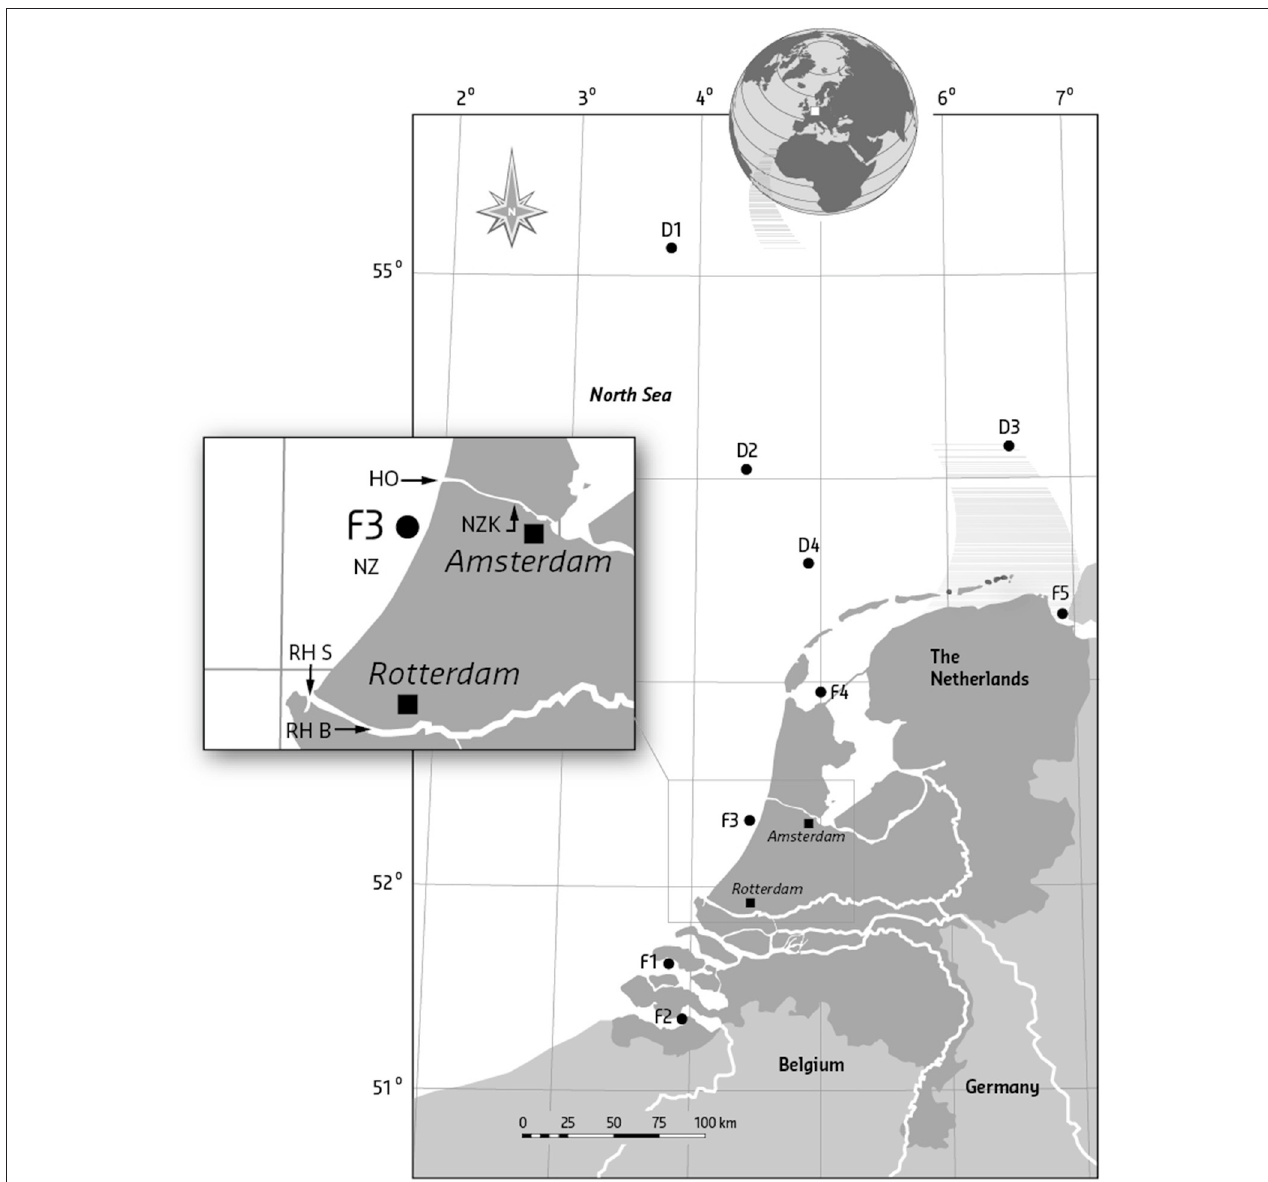
FIGURE 1 | Codes and geographical positions of sampling locations of flounder (F) and dab (D). F1, Eastern Scheldt, Hammen; F2, Western Scheldt, Middelgat/Molenplaat/ Bath/Saaftinge; F3, North Sea coast, between IJmuiden and Scheveningen; F4, Waddenzee, between Wierbalg and Breezanddijk; F5, Ems-Dollard, Bocht van Watum; Dab were sampled at the open North Sea: D1, Doggerbank; D2, ca. 150km NW of Terschelling; D3, ca. 70km N of Borkum; D4, ca. 60km NW of Terschelling; D5, ca. 90km W. of Callantsoog. The box shows the position of the additional sampling sites from the 1996 survey: RHS,